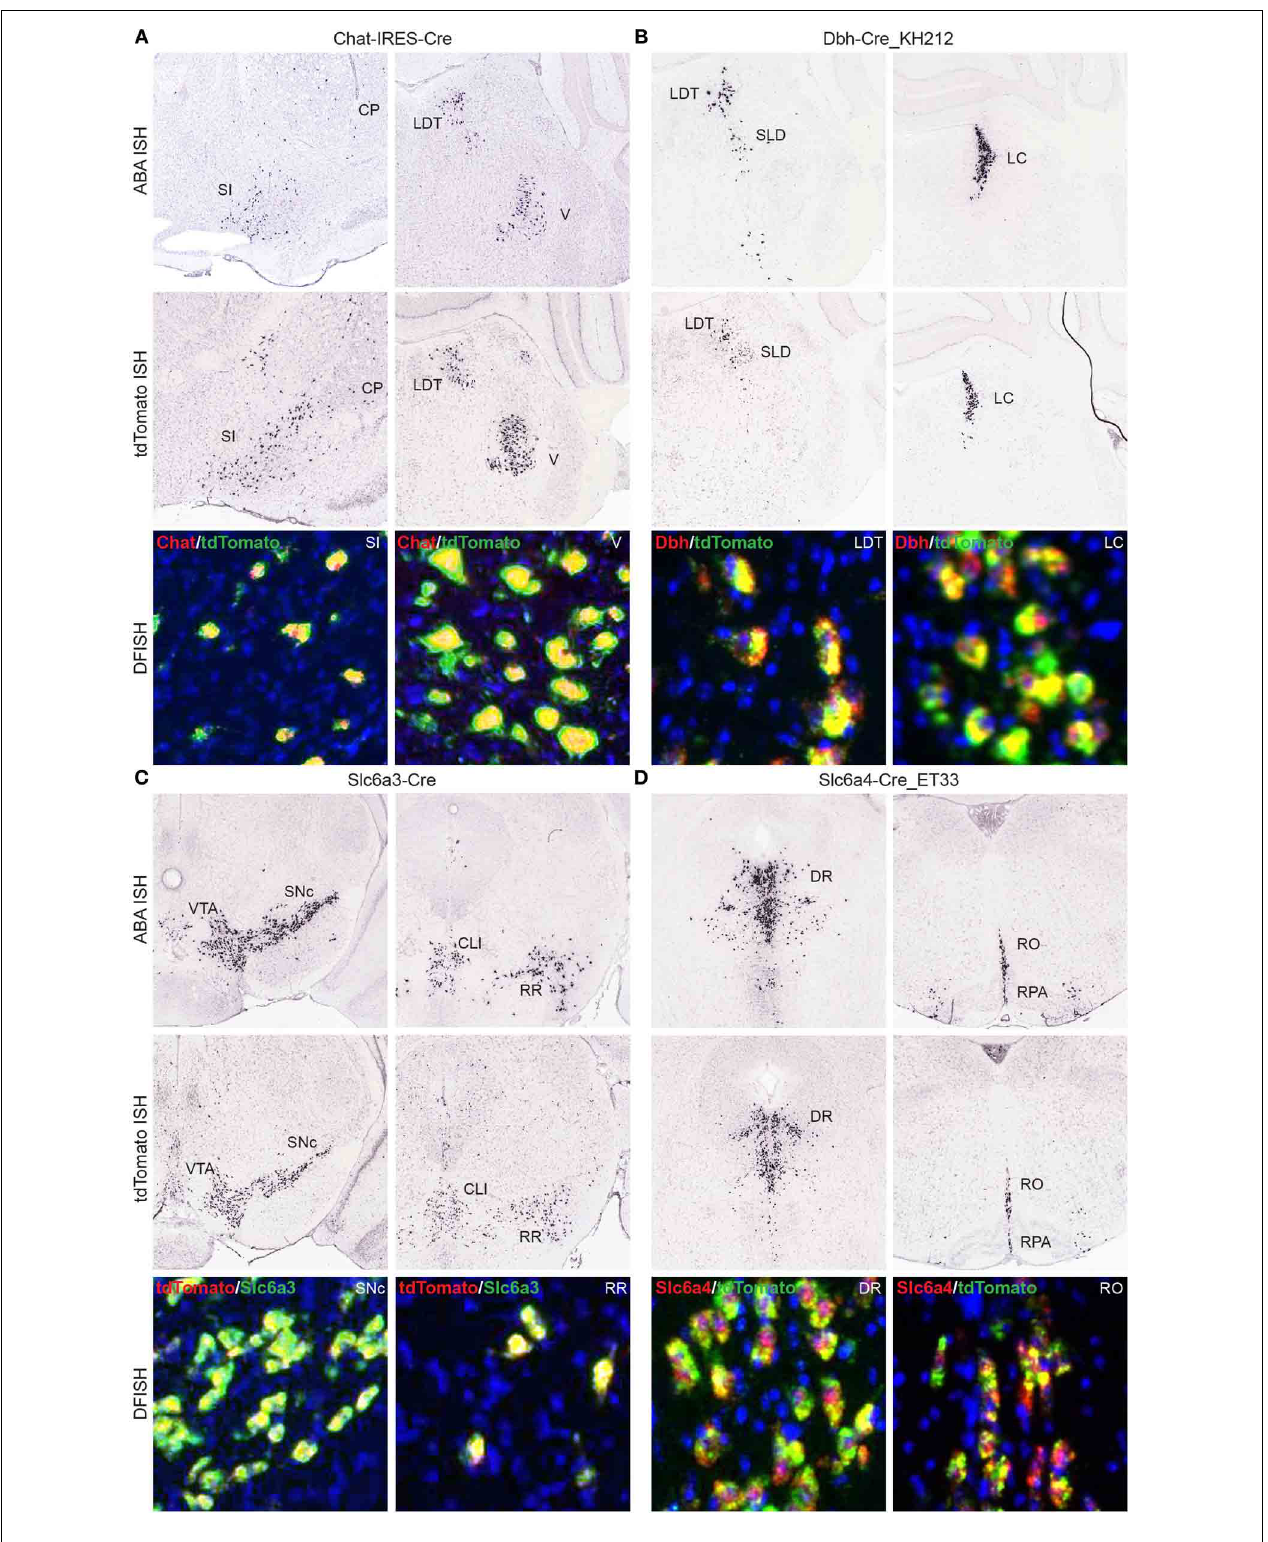
FIGURE 7 | Cre lines provide genetic access to specific neuromodulatory cell types and brain regions. Endogenous gene expression and tdTomato reporter ISH images show the faithful recapitulation of regional expression patterns between Cre line reporter expression at P56 and the corresponding